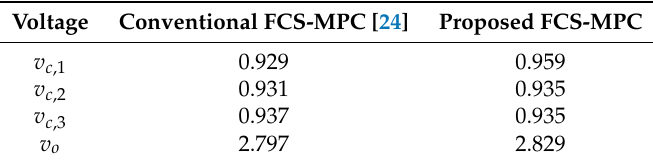
Figure 7. Experimental results for conventional FCS-MPC [24]. ( a ) cell voltage; ( b ) output voltage and current; ( c ) key-waveforms harmonic spectra. Table 3. Fundamental cell voltages (50 Hz) p.u. w.r.t DC voltage.